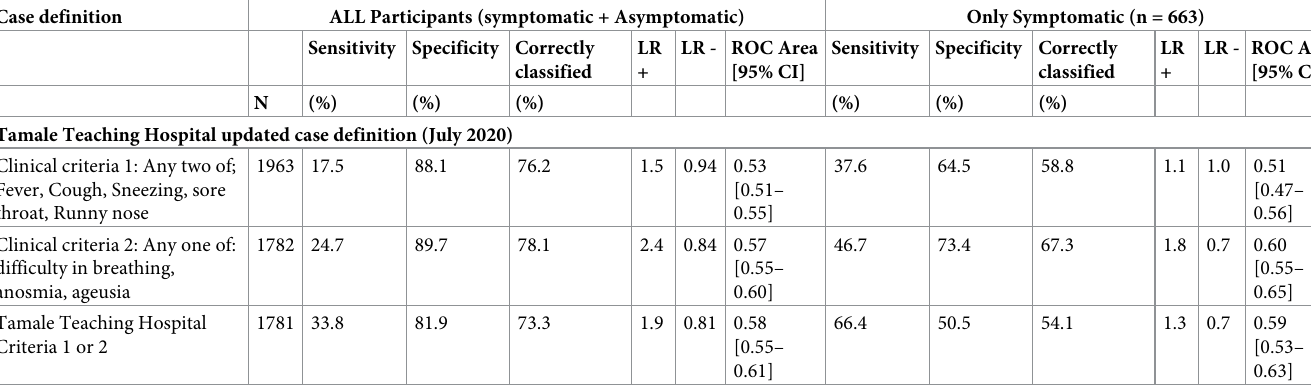
Table 5. Receiver operator characteristics of combination of